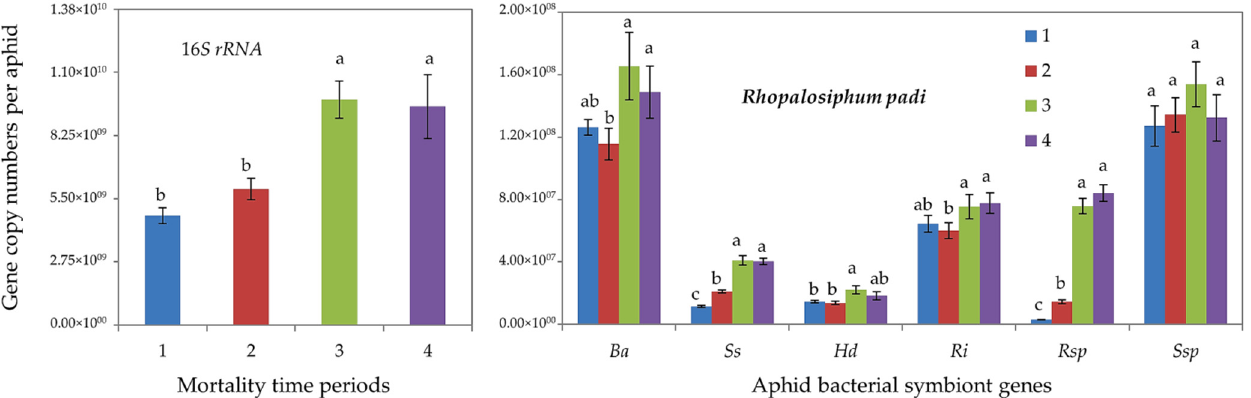
Figure 2. Abundance (mean gene copy numbers ± SD; n = 20) of bacterial symbionts of aphids ( Rhopalosiphum padi ) under chronic exposure to 31 °C. Dead aphid individuals were divided into four mortality time periods, i.e., 1–4, representing susceptible-to-tolerant thermal threshold levels. 16S rRNA = total eubacterial rDNA gene; Ba = Buchnera aphidicola ; Ss = Serratia symbiotica ; Hd = Hamiltonella defensa ; Ri = Regiella insecticola ; Rsp = Rickettsia spp.; Ssp = Spiroplasma spp. Differ- ent letters at the tops of the treatment bar show significant differences between treatments (one-way ANOVA; p ≤